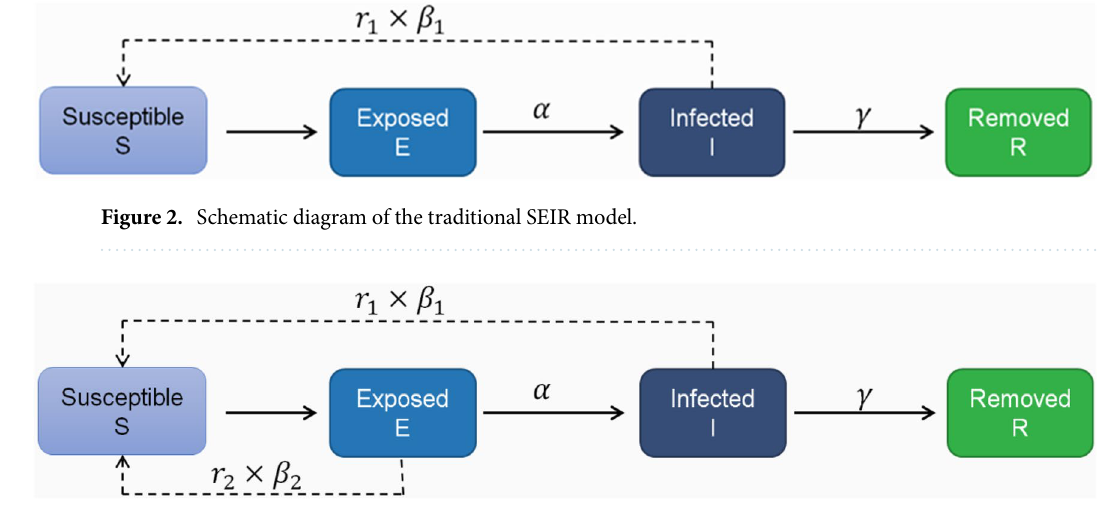
Figure 3. Schematic diagram of SEIR model considering latent